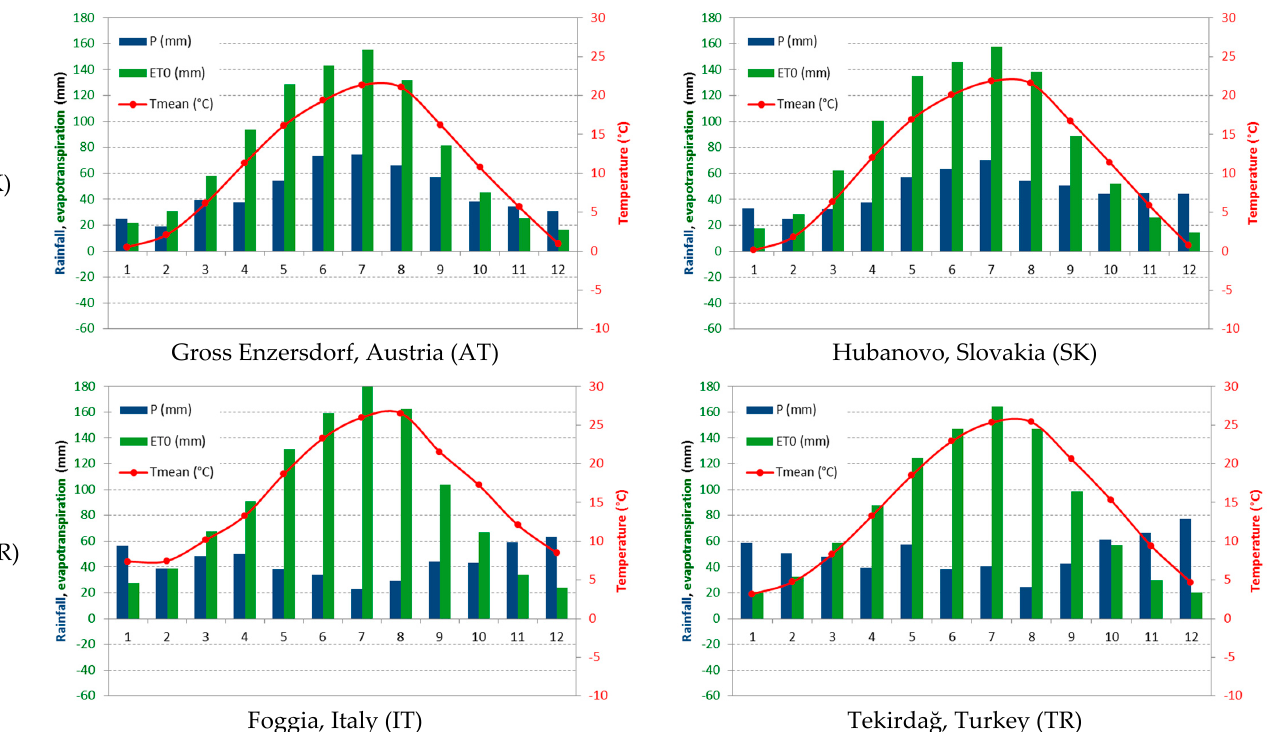
Figure 2. Climatological diagrams for different meteorological stations along a broad transect in Europe for the period 1992–2012. P is precipitation (mm); ET0 is reference evapotranspiration (mm); Tmean is average temperature (°C). A two letter code refers to the countries.